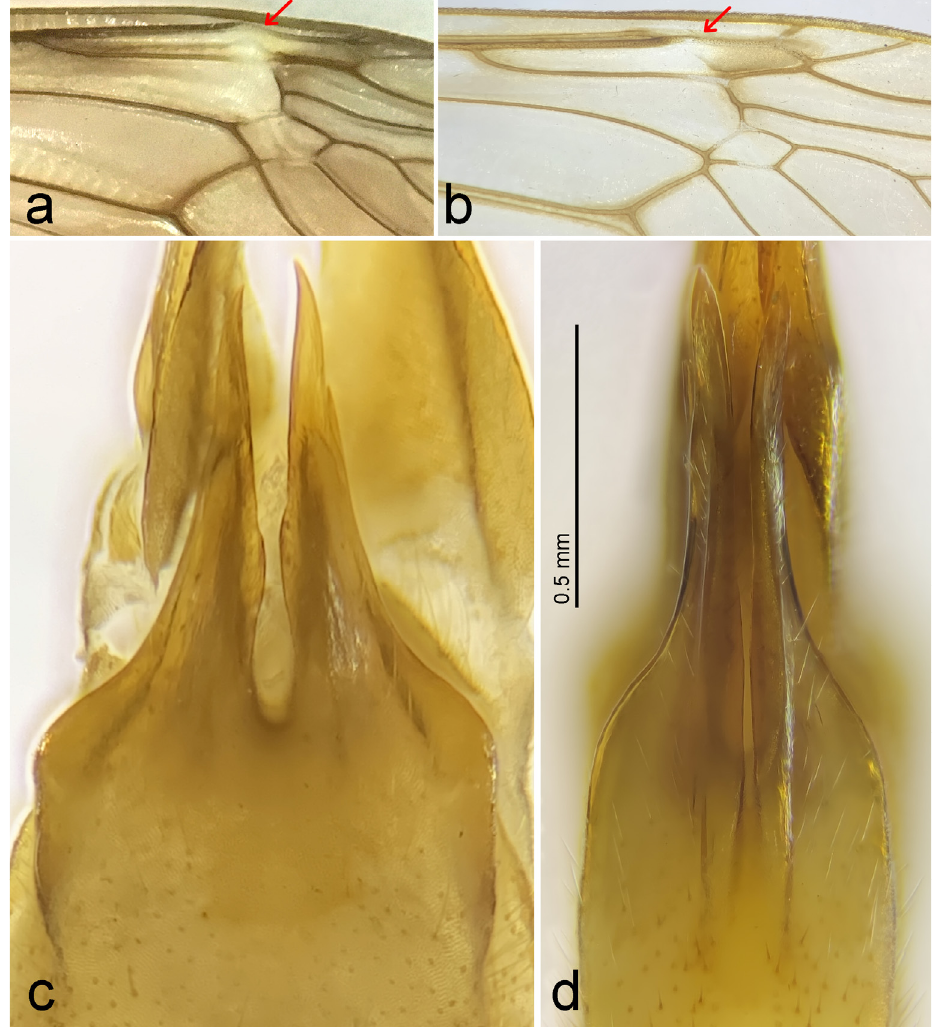
Figure 13. ( a ) Detail of wing of Zelandotipula parviceps ; ( b ) idem , Zelandotipula gelhausi sp. nov . ; ( c ) Detail of hypogynial valves, ventral view, of Zelandotipula parviceps ; ( d ) idem , Zelandotipula gelhausi sp. nov